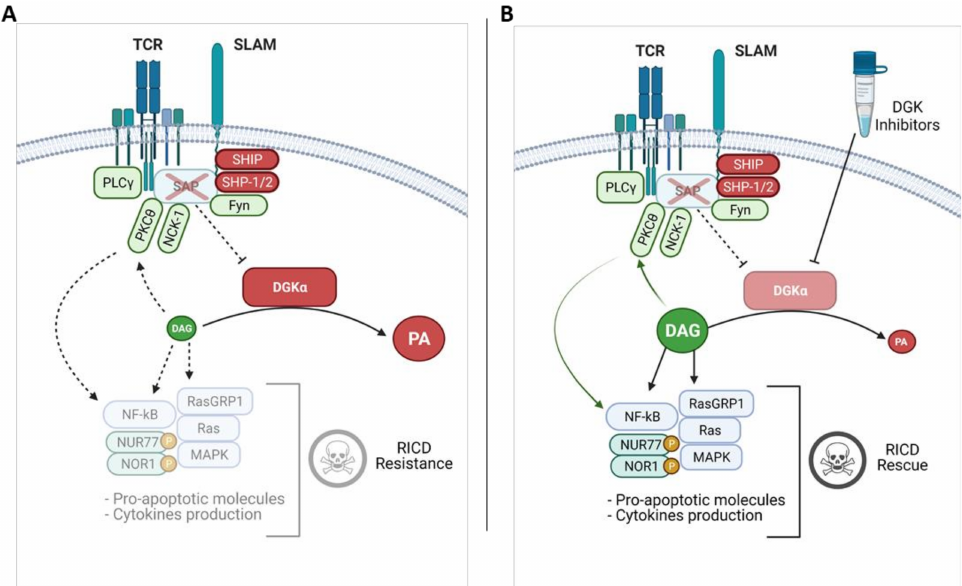
Figure 3. Reduced DAG signalling in XLP-1 and effects of DGK inhibitors. ( A ) In XLP-1 lymphocytes, the absence of SAP allows the binding of SHIP or SHP-1/2 phosphatases to SLAM family receptor ITSMs, promoting the transduction of inhibitory signals which attenuate the TCR signaling strength. In SAP-deficient conditions, DGK α shows increased activity and metabolizes DAG, contributing to RICD resistance. ( B ) This defect can be rescued by treating the cells with DGK α inhibitors which restore DAG signalling. DAG mediated PKC θ and MAPK activation leads to NUR77/NOR1 expression and phosphorylation, promoting